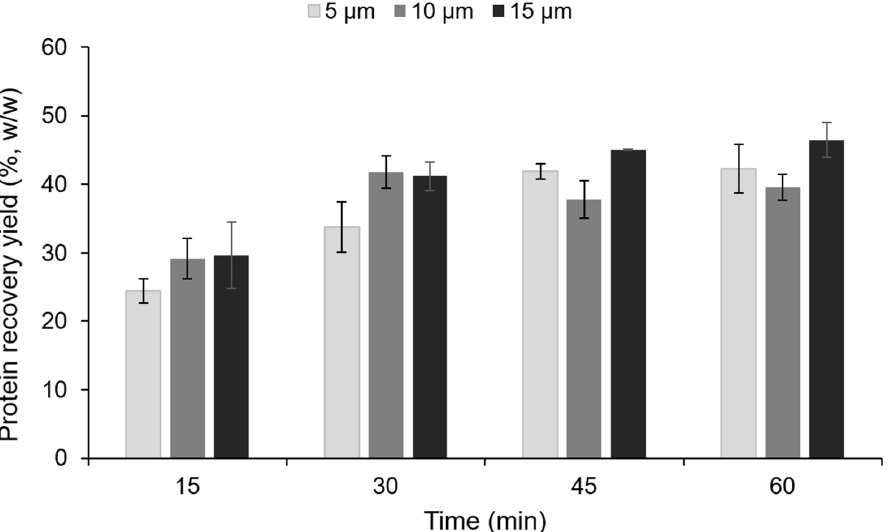
Figure 1. Protein recovery yield (%, w / w ) from defatted AOB seeds by ultrasonication-assisted extraction at 50 °C.